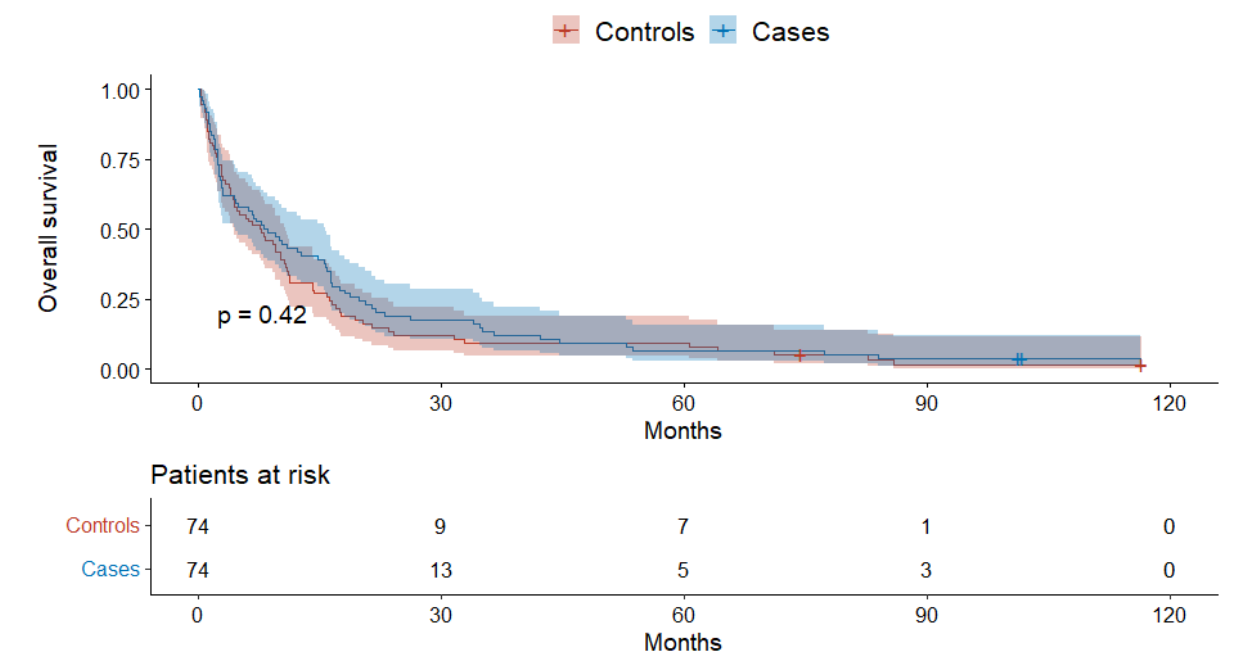
Figure 2. The overall survival of patients with HCC.